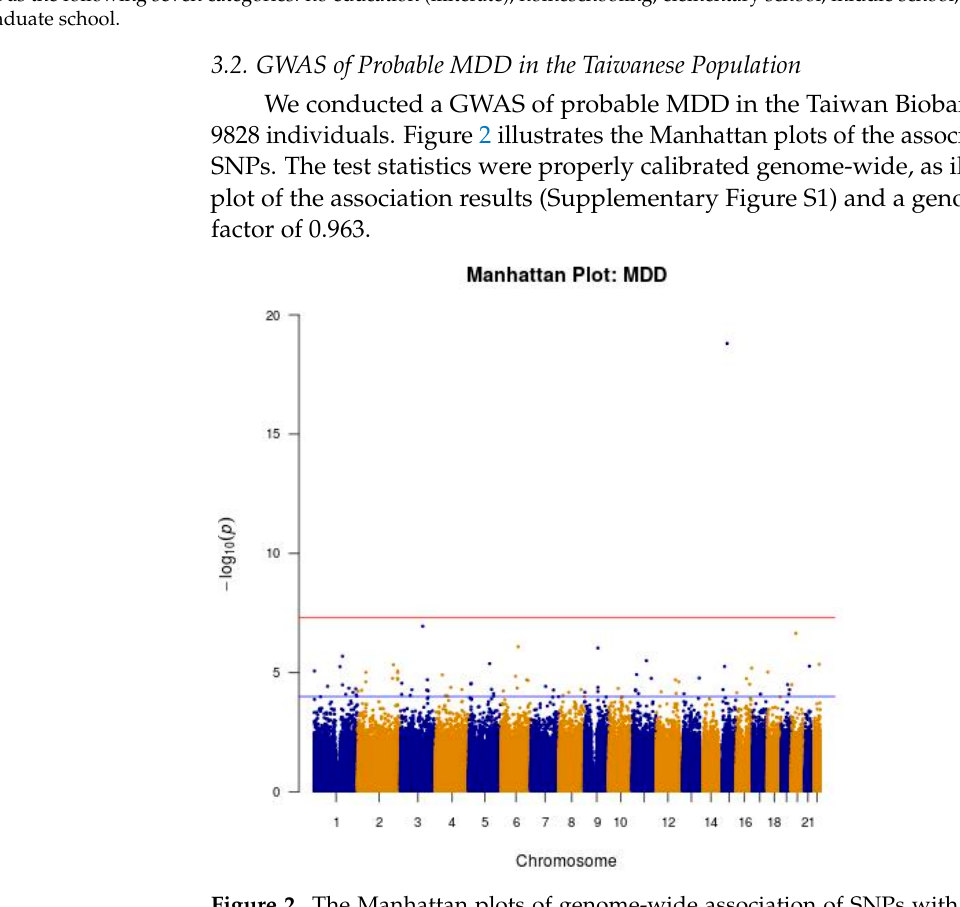
Figure 2. The Manhattan plots of genome-wide association of SNPs with MDD. The Manhattan plots were generated by using the p values of SNPs. A single SNP is indicated by a point, where a higher point (higher negative log 10 p value) demonstrates a more significant association. The red horizontal line is displayed as the genome-wide significance level ( p = 5 × 10 − 8 ). The blue horizontal line is displayed as the significance level of p = 1 × 10 − 4 . Hence, points above the blue horizontal line illustrate SNPs with a p value of less than 1 × 10 − 4 . Y-axis: -log 10 ( p value) of each SNP; X-axis: chromosomes demonstrated with blue and orange colors. MDD = major depressive disorder; SNPs = single nucleotide polymorphisms.